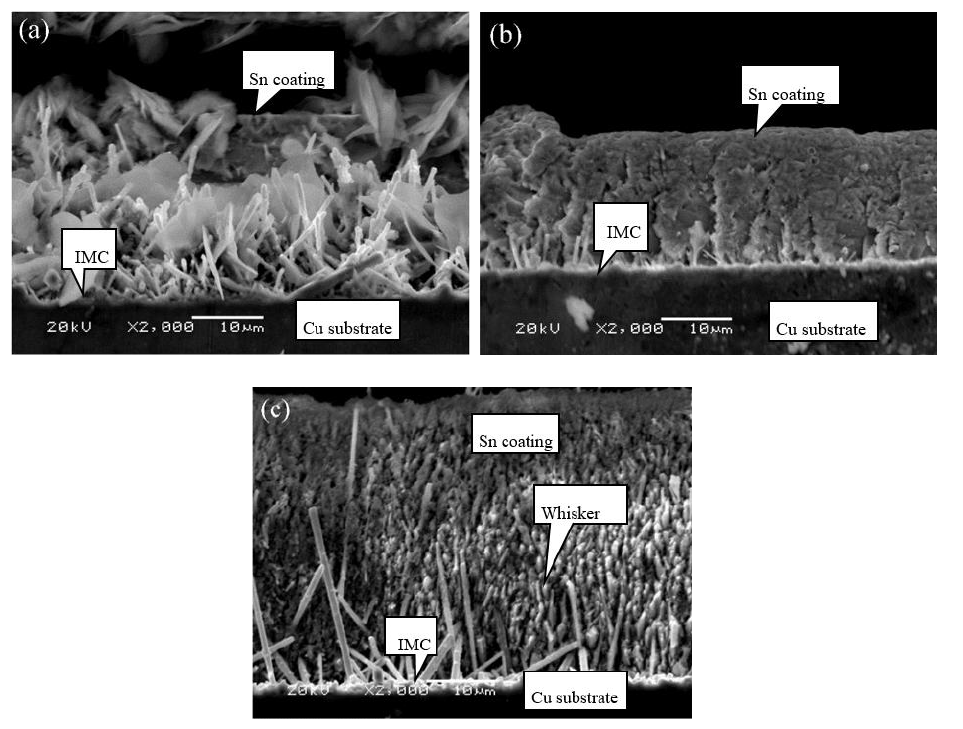
Figure 7. Cross-sectional microstructure of C70250 foils coated at 280 °C with different dipping time: ( a ) 4 s, ( b ) 8 s, and ( c ) 16 s. ( a ) 4 s, ( b ) 8 s, and ( c ) 16 s.